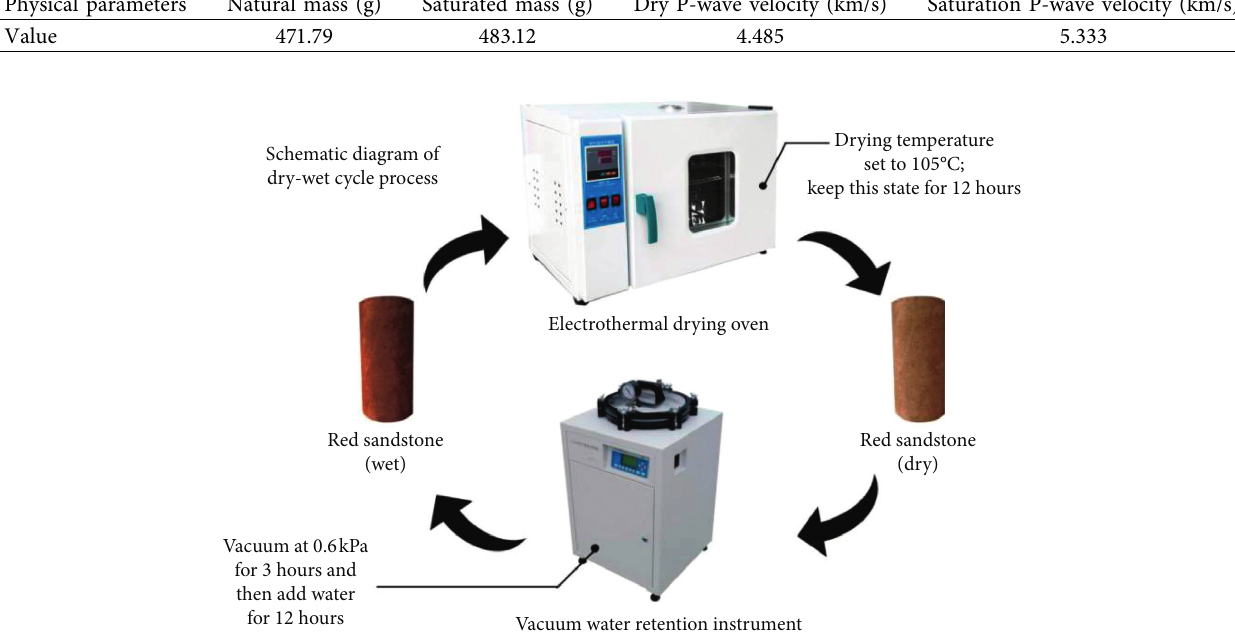
Figure 3: The dry-wet cycle process of the specimens.